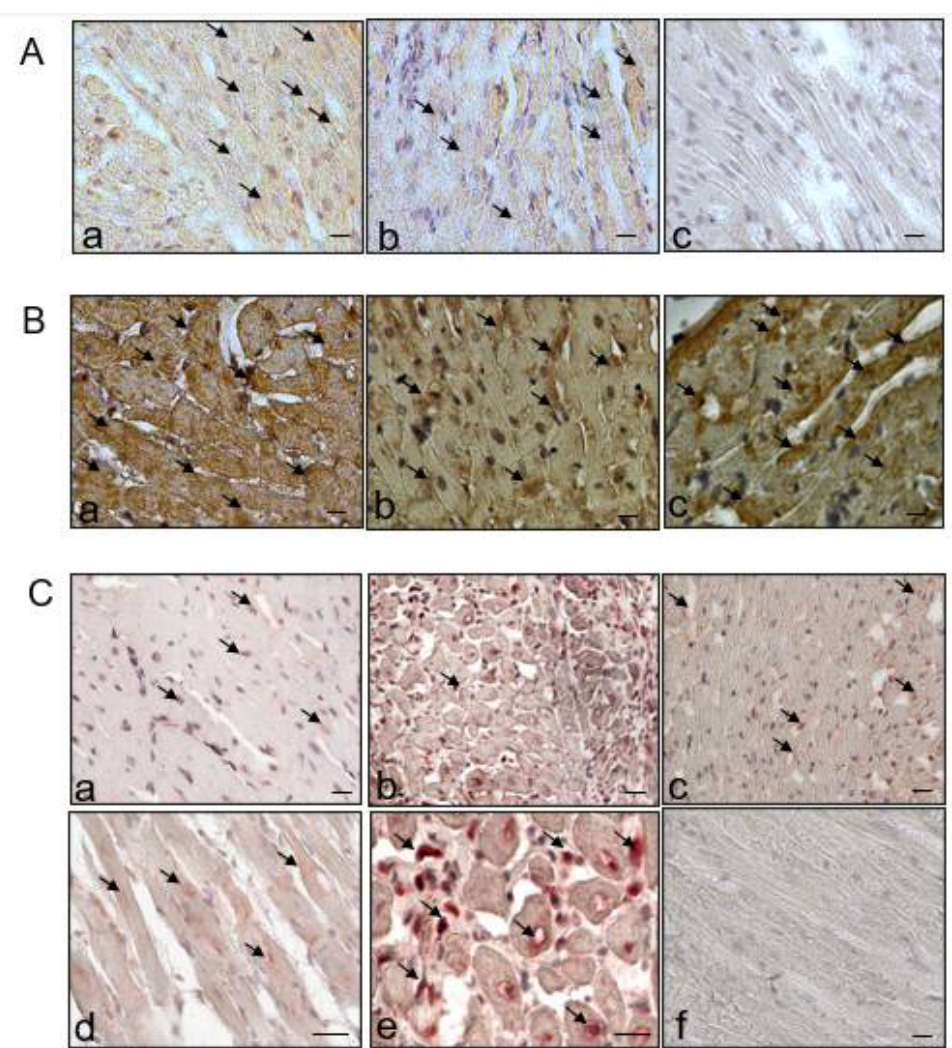
Figure 3. Molecular biological analysis of left ventricular 7 days after myocardial infarction. Western blot analysis of car- diac transporters (NHE1, NBC, NCX, SERCA2a), matrix metalloprotease 9 (MMP9), markers of fibrosis (smad, TGF-β1), marker of necroptosis (MLKL). ( A ) Representative Western blots: sham operation, MI vehicle, MI treated with Empa, sham operation treated with Empa. ( B ) Densitometric data of proteins are mean ± SEM (bars); * P < 0.05; ** P < 0.01; *** P < 0.001; two-tailed unpaired t -test.